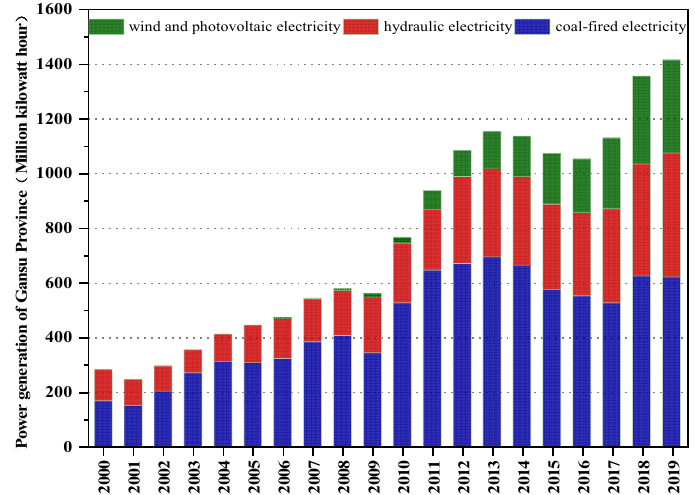
Figure 2. Electricity structures in Gansu Province from 2000 to 2019.